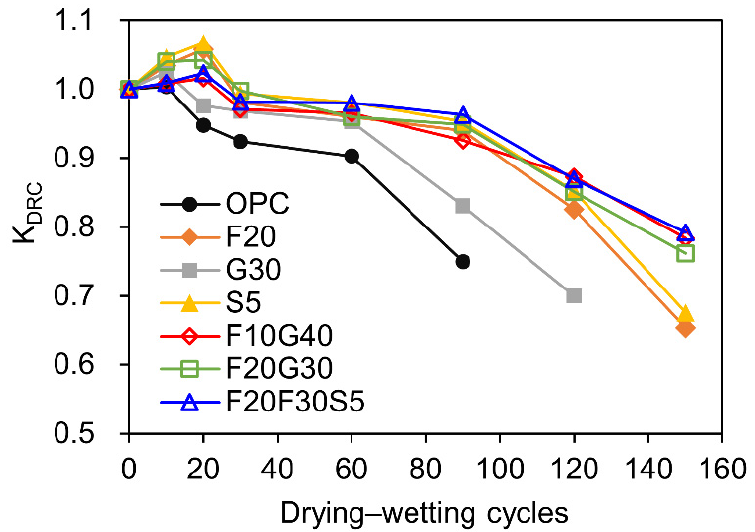
Figure 3. Evolution of K DRC of concrete with different mix proportions under DW cycles with SA (5% Na 2 SO 4 solution). Table 8. Fitting parameter and R-square of the empirical formulas for DRC. Mix Proportions Fitting